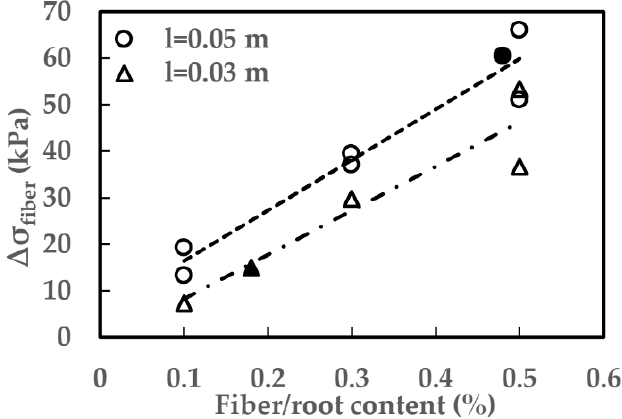
Figure 10. The relationship between fiber (root) content and reinforced tensile strength. The letter l in the diagram stands for the fiber length. The hollow circles and triangles are the data from Meriem et al. [24], while the solid circle and triangle refer to the reinforced tensile strength of AS and AM in this study, respectively.